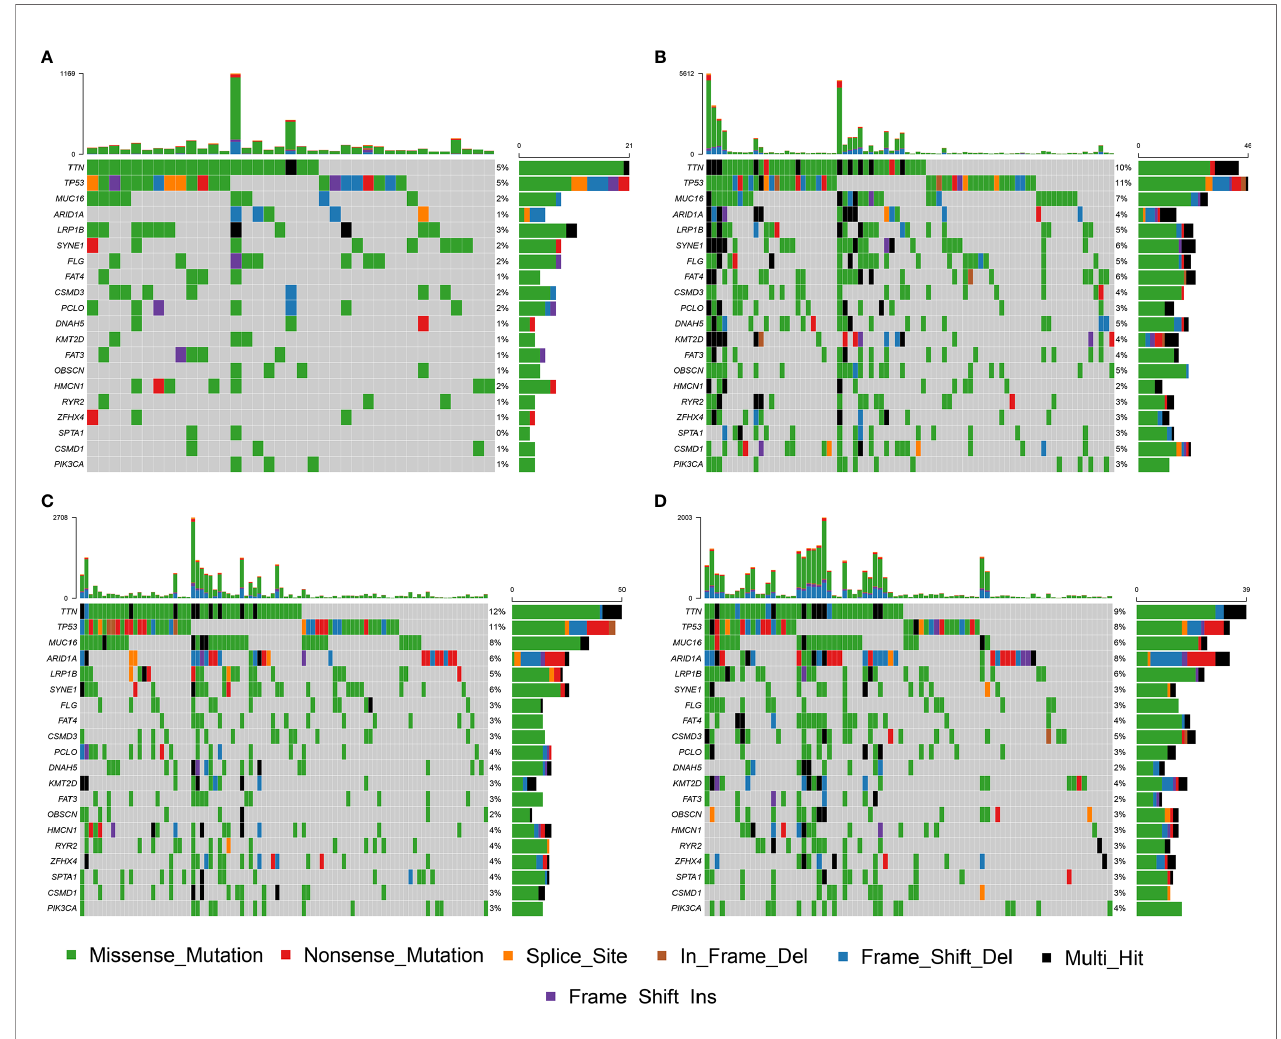
FIGURE 13 | SNP alteration was identi fi ed in C1 (A) , C2 (B) , C3 (C) , and C4 (D)